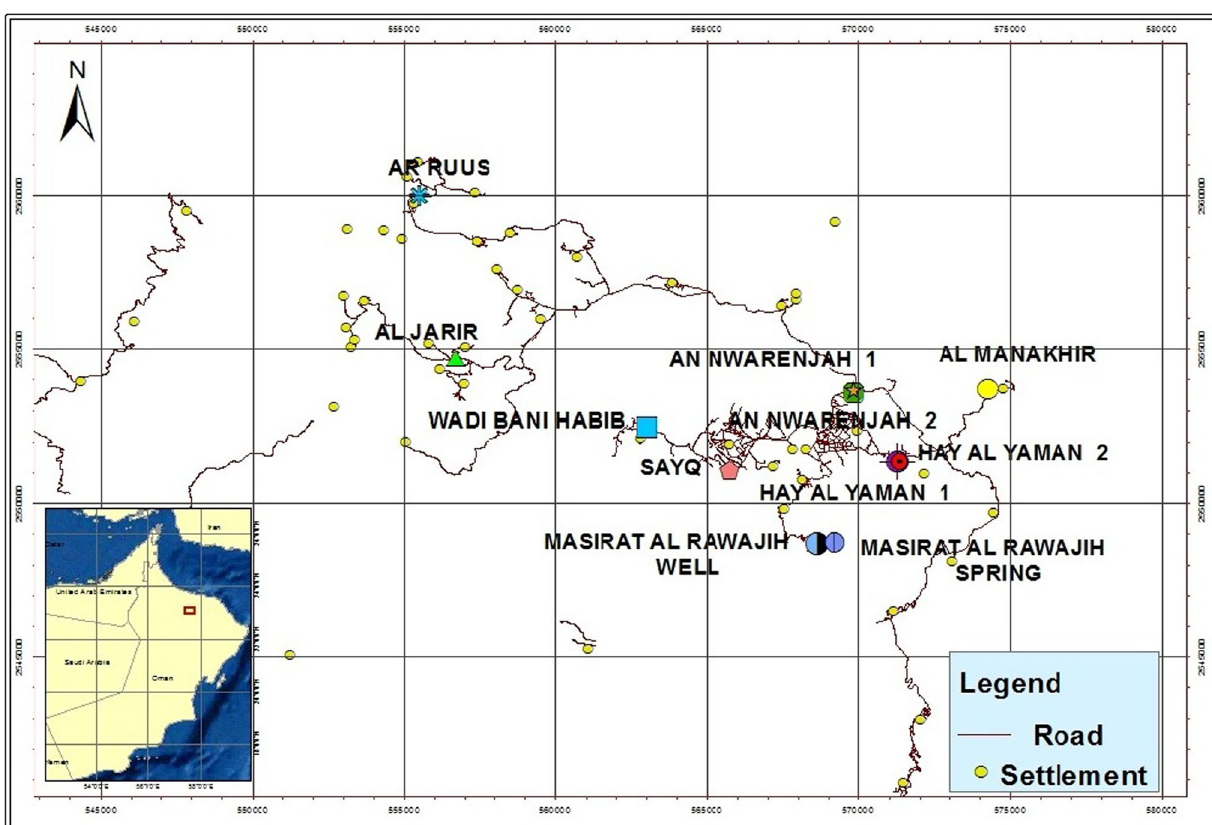
Fig. 1 The locations of sampled groundwater resources of the study